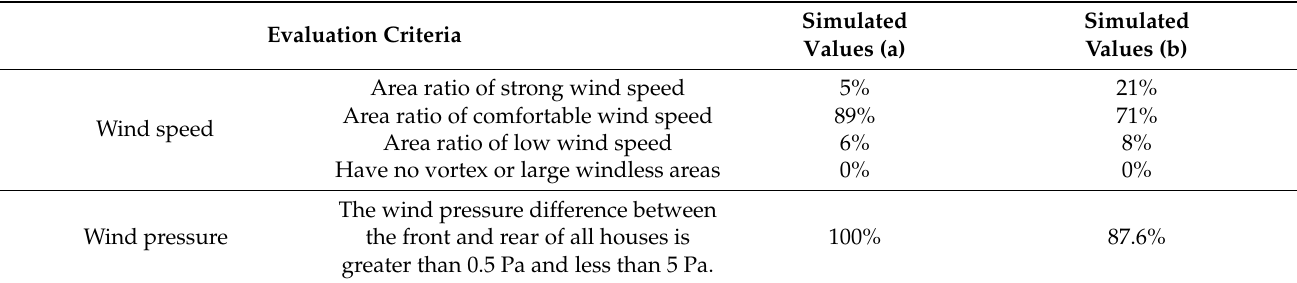
Table 2. Wind environment evaluation of Feng Shui and non-Fen Shui in